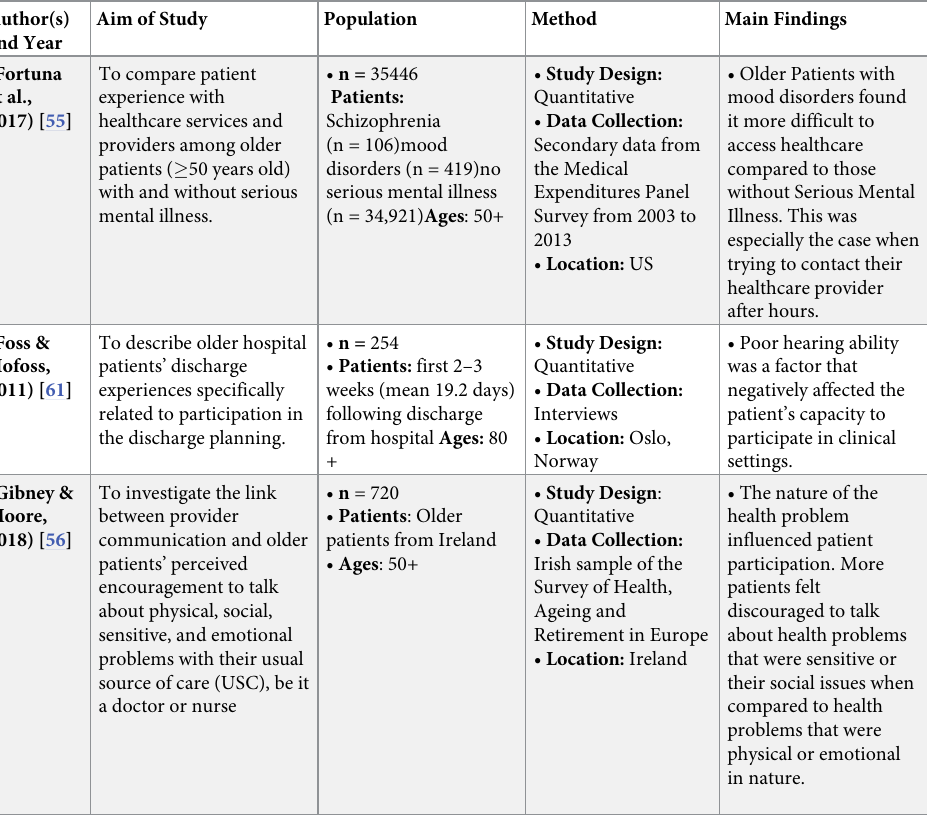
Table 4. Characteristics of the quantitative